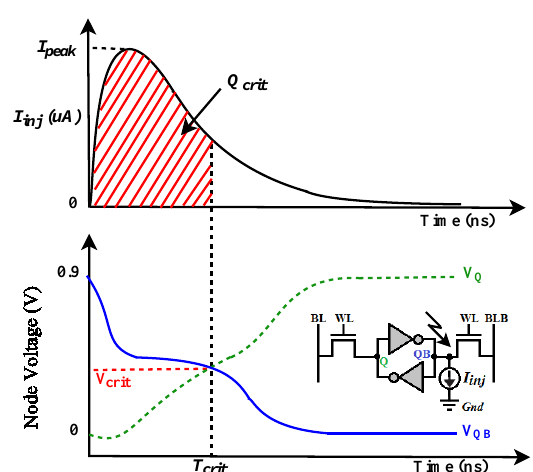
Figure 5. Graphical representation defining the critical charge. (top) Shows the transient behavior of the current pulse representing a possible particle strike. (bottom) V Q and V QB are the storage node voltages of the SRAM cell. Simulation setup for an high energy particle hitting a sensitive node V QB storing ’1’ of a SRAM cell is given in the inset.